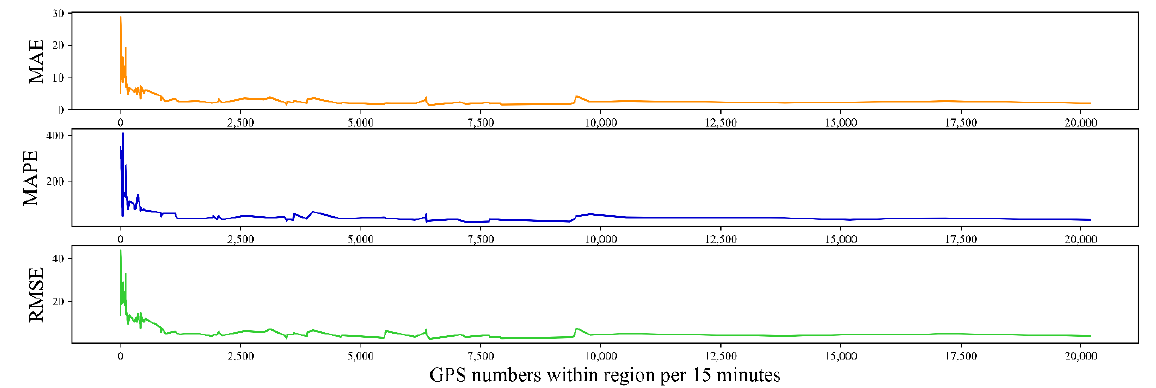
Figure 9. The impact of the numbers of GPS points within region.